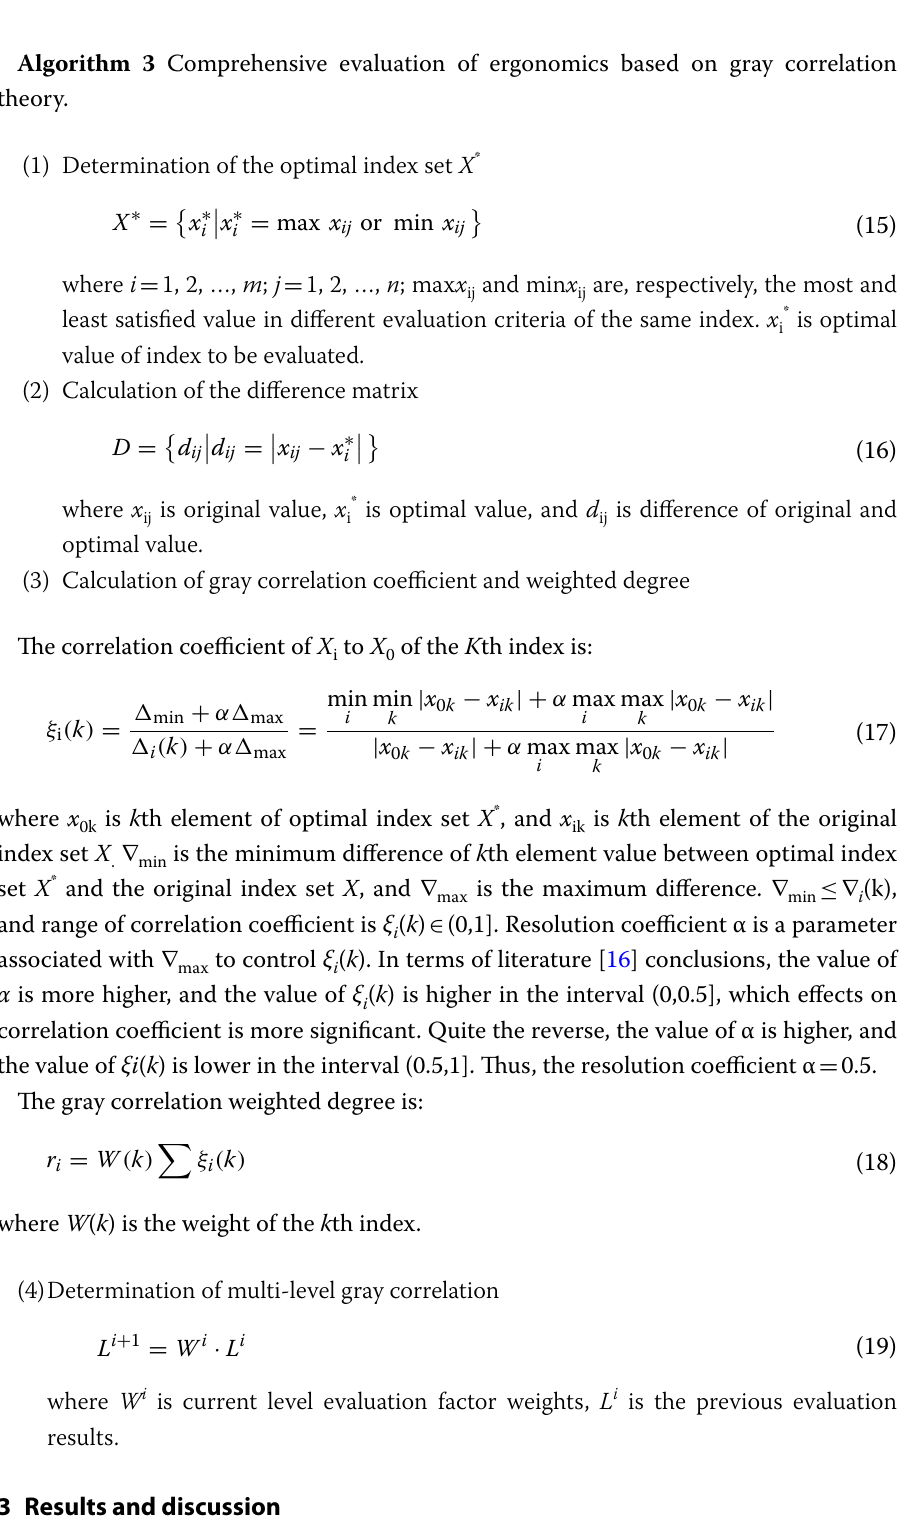
Algorithm 3 Comprehensive evaluation of ergonomics based on gray correlation